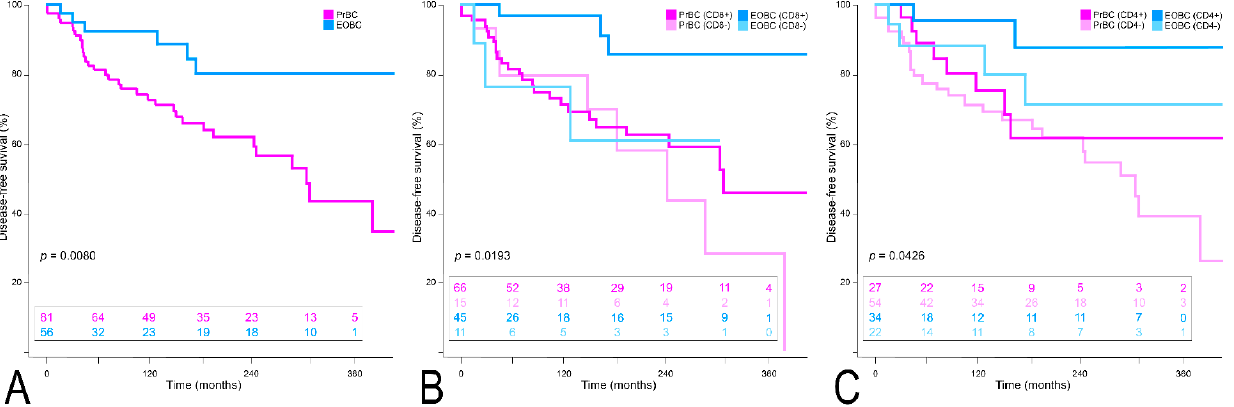
Figure 5. Disease-free survival analysis. ( A ) Overall population. ( B ) According to CD8+ TILs. ( C ) According to CD4+ TILs.